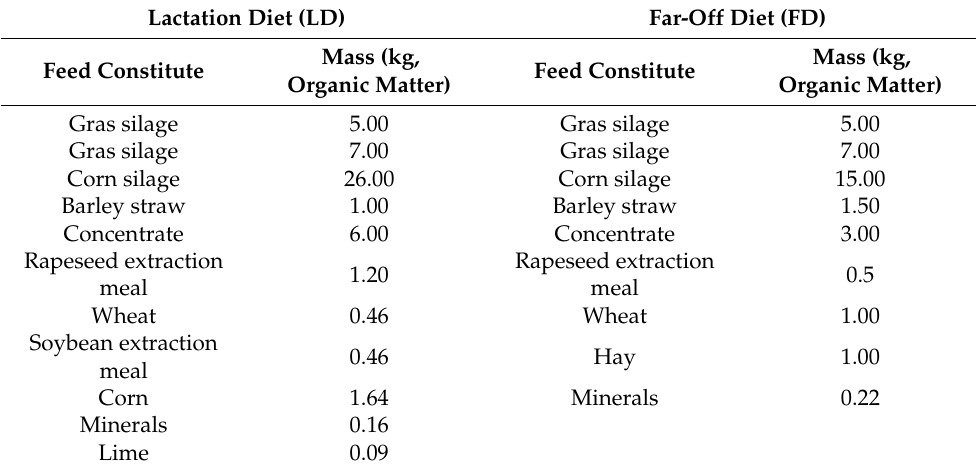
Table 1. Detailed lactation diet (LD) and far-off diet (FD) composition offered to cows of group I and group II, respectively.